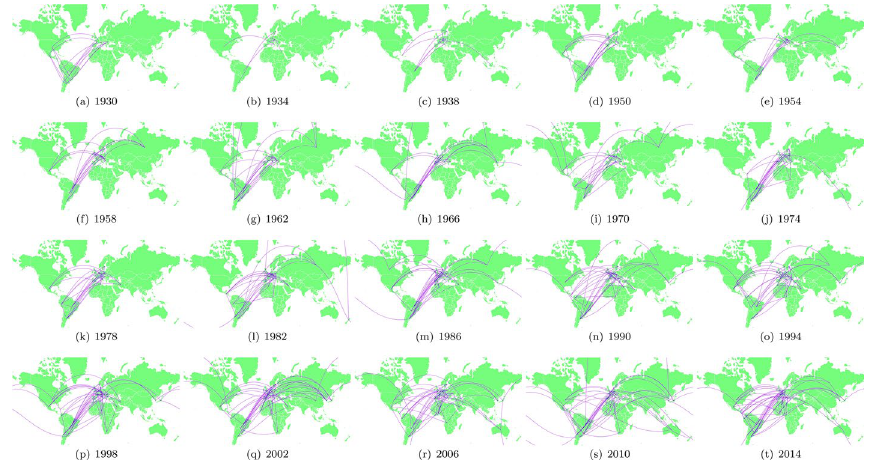
Fig. 2 Football network for each World Cup. Each figure depicts the network of a World Cup tournament, with edges representing World Cup matches between participant countries. The first few World Cups mainly involved countries from Europe and South America. With the globalization of international football, more countries, especially Asian and African countries, get involved in the World